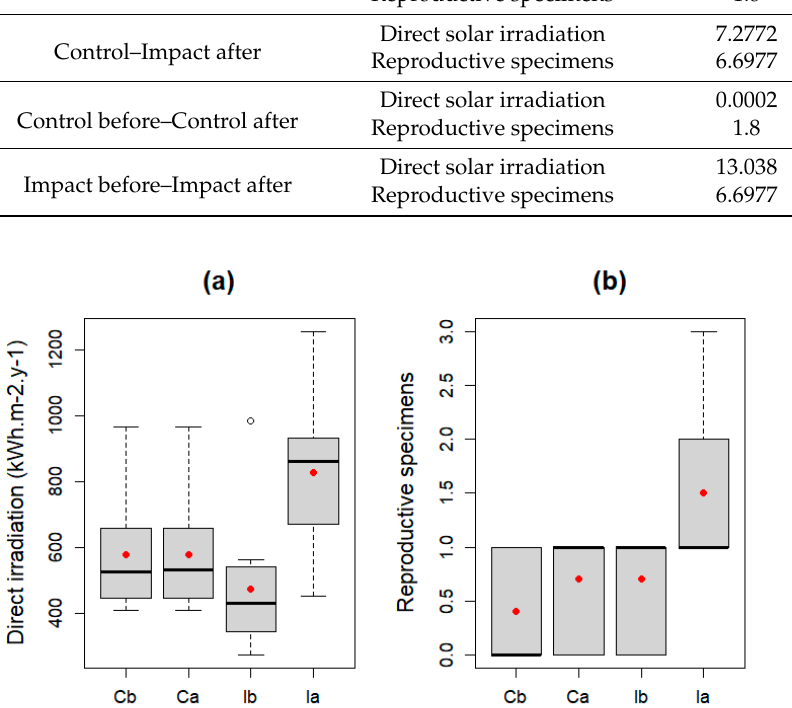
Figure 2. Boxplot of ( a ) annual direct solar irradiation and ( b ) total number of reproductive specimens (red point represents the mean value). Cb: control before, Ca: control after, Ib: impact before, Ia: impact after.